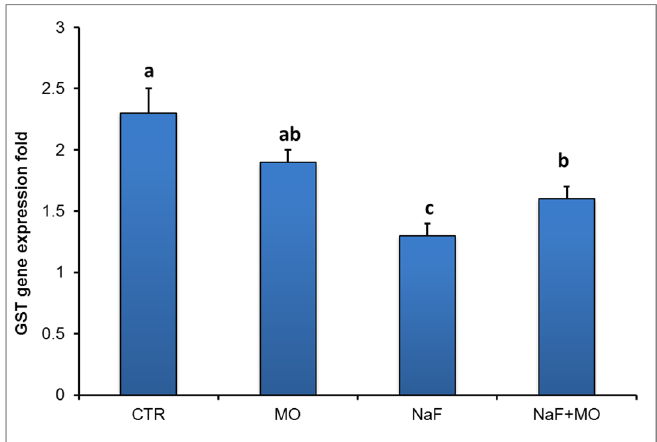
Figure 3. Effect of Moringa oleifera (MO) leaves extract on glutathione S transferase mRNA expression in O. niloticus . Six samples were analyzed to obtain an average concentration for each treatment.